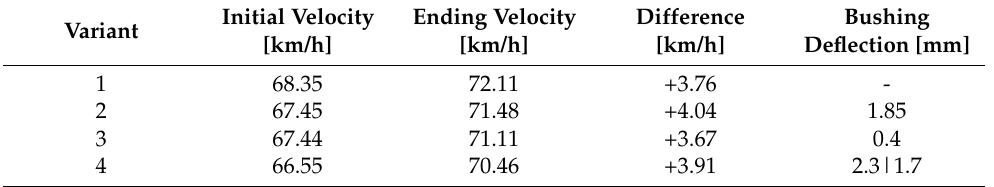
Figure 11. Differences in speed of the vehicle along the curve for four bushing variants (colors correspond to these presented in Figure 9). Table 7. Values read from the